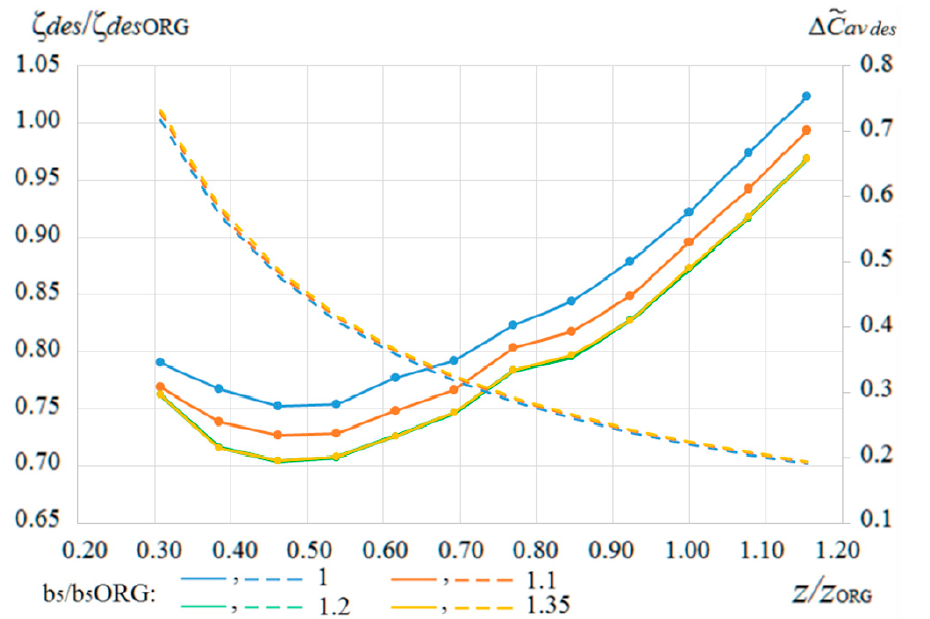
/ , / z z b b and their 5 5 ORG ORG